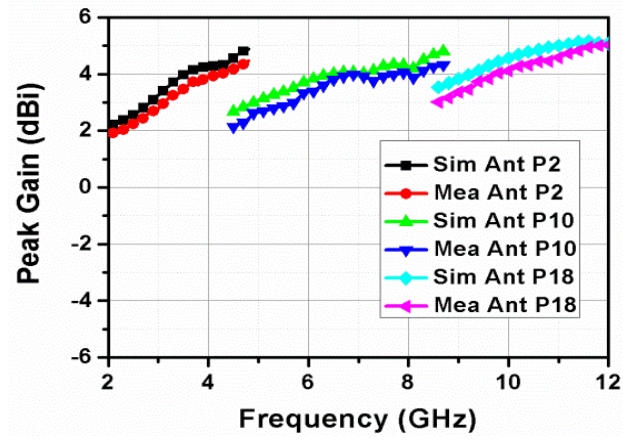
Figure 31. Peak gains of the communication antennas.